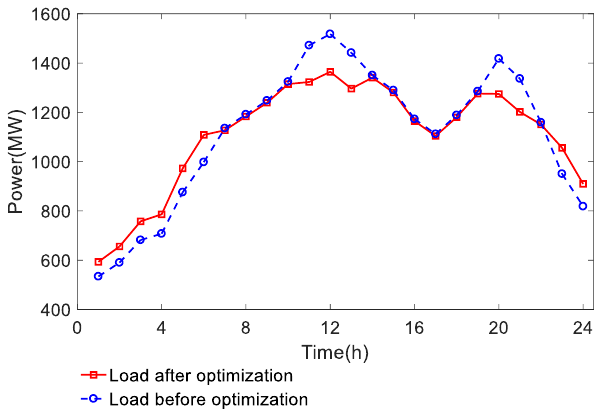
Figure 6. Electric load curves before and after the system’s implementation of demand response.